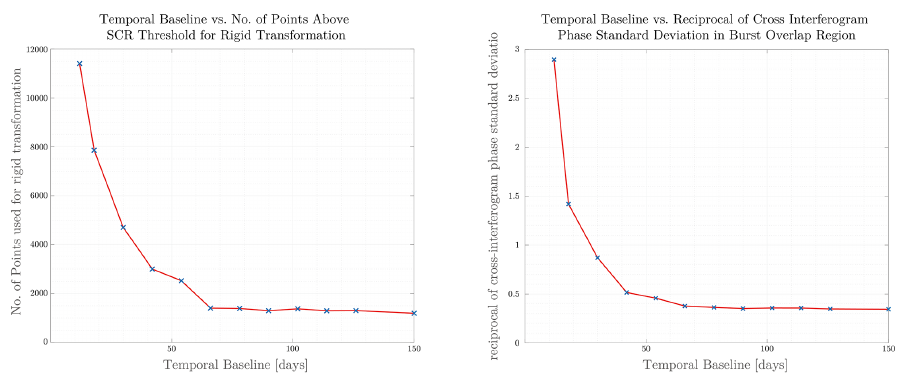
Figure 10. ( Left ) the number of available points with SCR greater than 7 dB used in the cross-correlation method as a function of temporal baseline. ( Right ) the average reciprocal of cross-interferogram phase standard deviation in burst overlap area as a function of temporal baseline. When the reciprocal value approaches 0.3, the scene will become totally noisy, meaning it is very unlikely to estimate correctly the ESD phase and slope from the